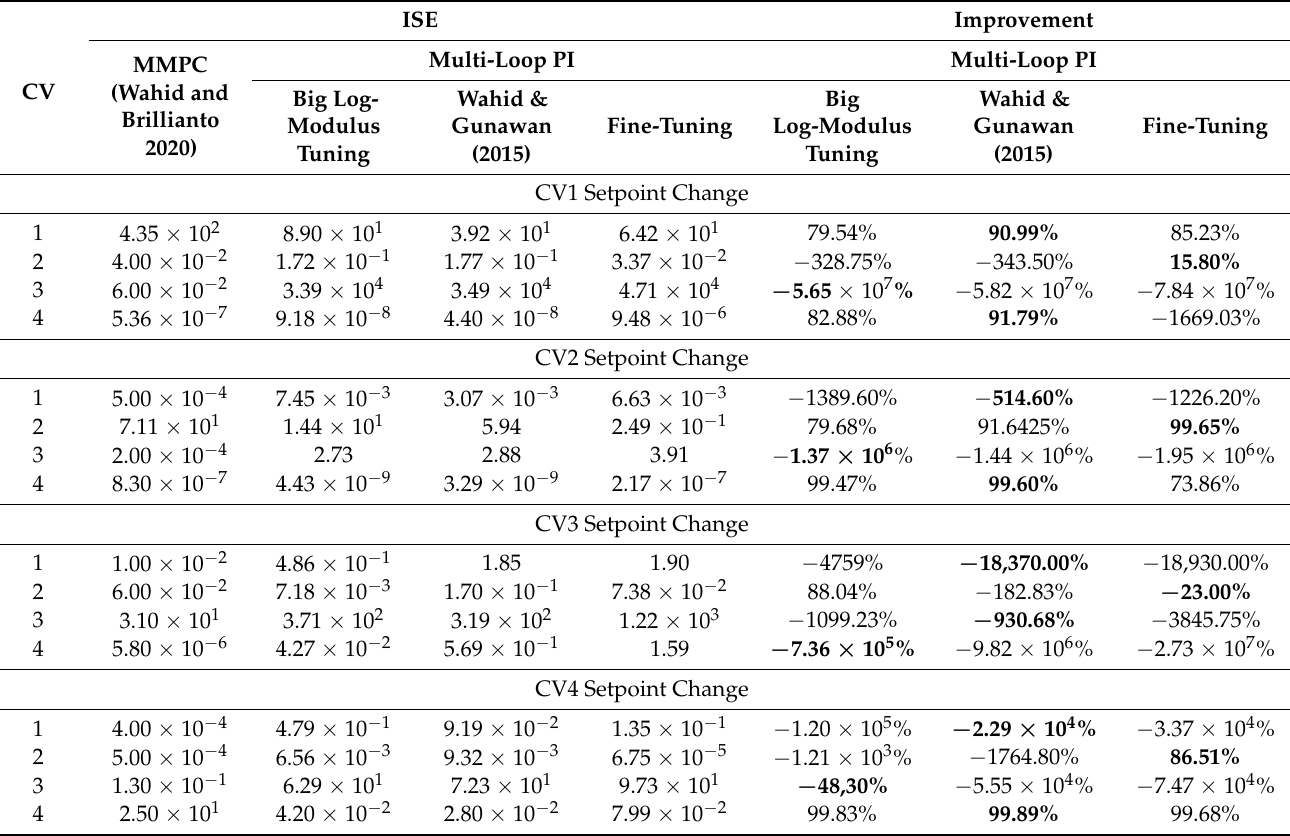
Table 14. ISE comparison of MMPC and multi-loop